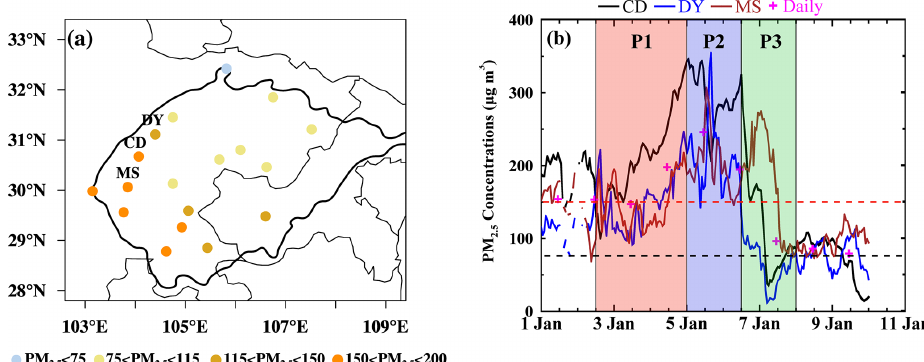
Figure 2. (a) Surface PM 2 . 5 concentrations over 18 urban sites averaged during the heavy haze pollution during 2–7 January 2017 and (b) hourly variations of PM 2 . 5 concentrations observed at the three heaviest polluted cities Chengdu (CD), Deyang (DY), and Meishan (MS) (Fig. 1; Table 1) over 1–10 January 2017. The P1, P2, and P3 indicated, respectively, the formation, maintenance, and dissipation periods of heavy haze pollution with the light pollution level of 75µgm − 3 (black dashed line) and heavy pollution level of 150µg m − 3 (red dashed